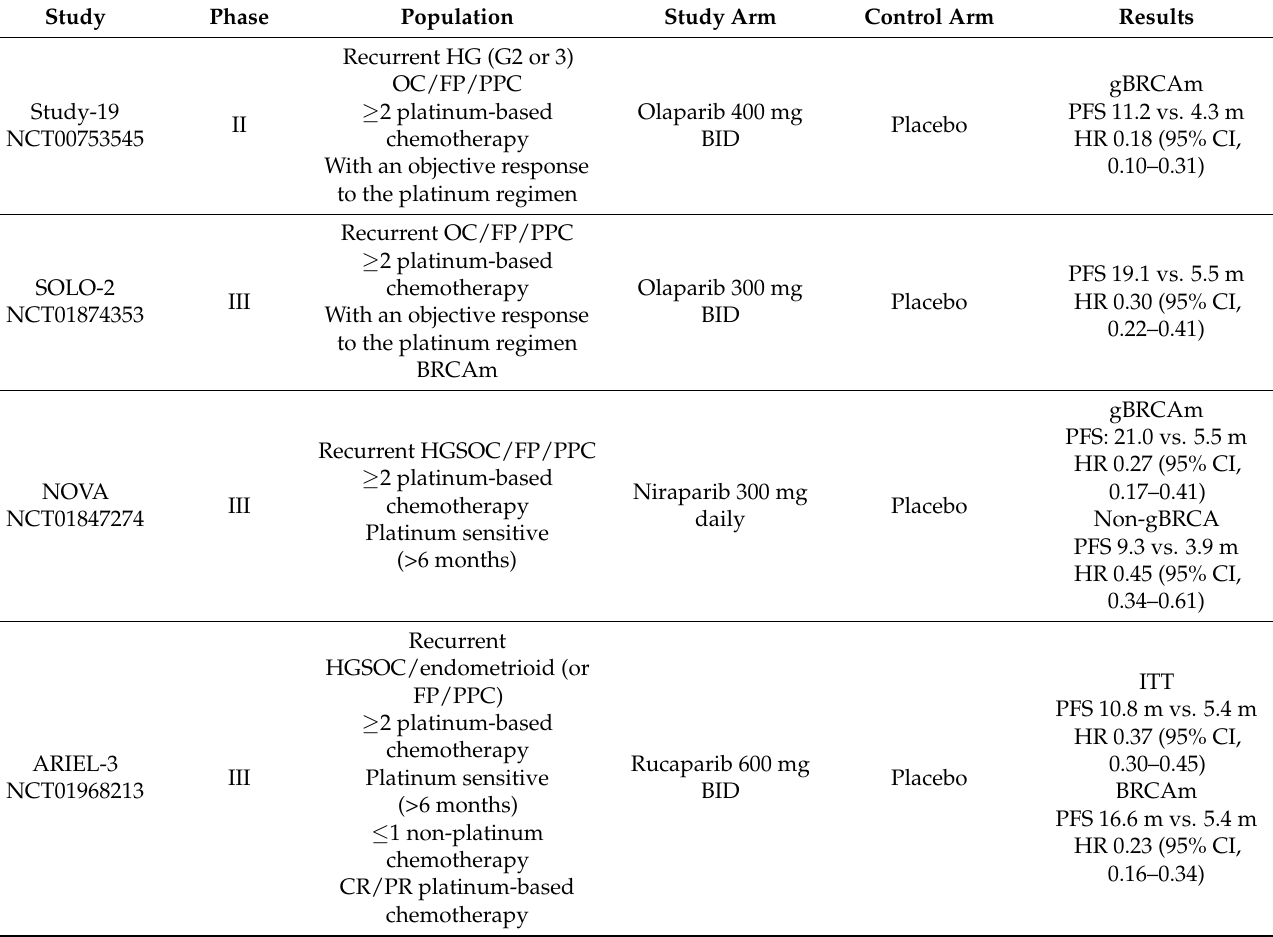
Table 2. Clinical trials of PARP inhibitors as maintenance in the recurrent